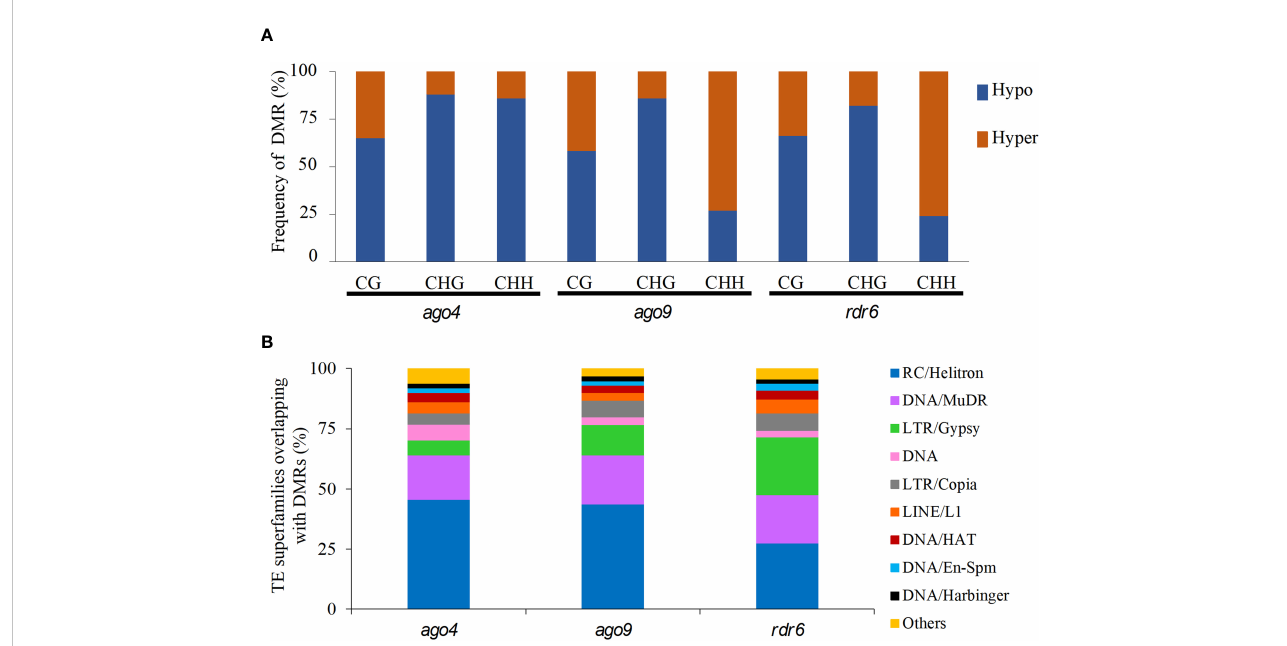
FIGURE 2 Quanti fi cation of hypo- and hypermethylated DMRs and their most represented TE superfamilies in three RdDM mutants. (A) Percentage of hypomethylated (Hypo) and hypermethylated (Hyper) DMRs in each mutant for each sequence context. (B) Representation of TE superfamilies within DMRs for all three mutants. The “ Others ” group includes the following TE superfamilies: DNA/Pogo, RathE1_cons, DNA/Mariner, SINE, RathE3_cons, DNA/Tc1. RathE2_cons, and